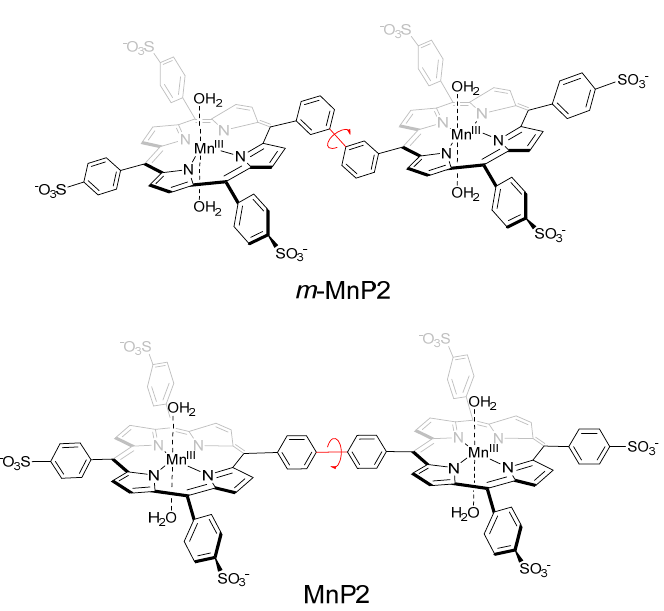
Figure 1. Chemical structure of m -MnP2 ( top ) designed with a biphenyl bridge connected at the meta -positions. MnP2 ( bottom ) is connected at the para - position of the biphenyl.